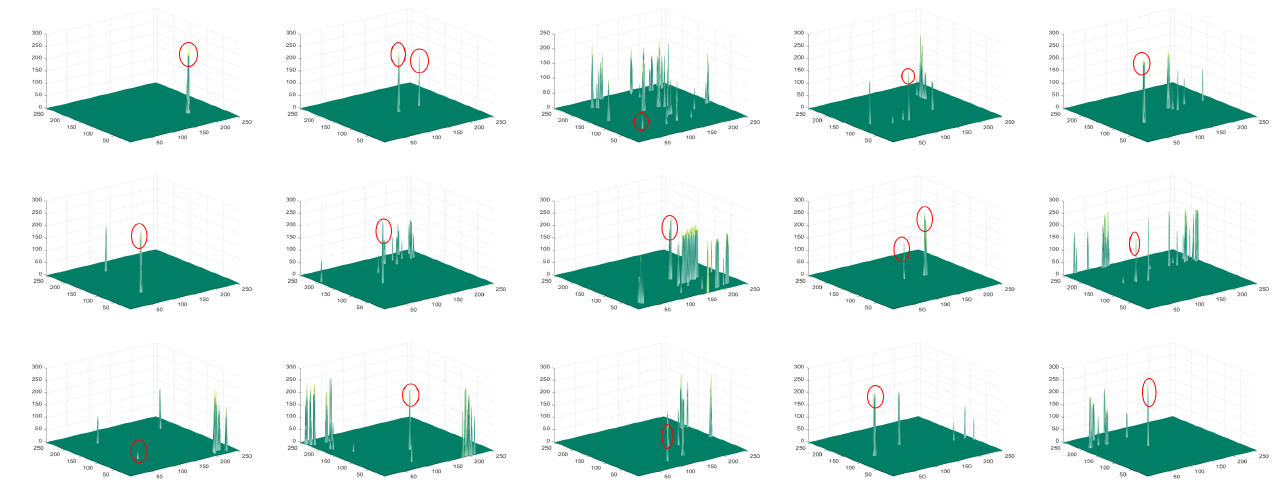
Figure 17. Three-dimensional displays of the detection results in Figure